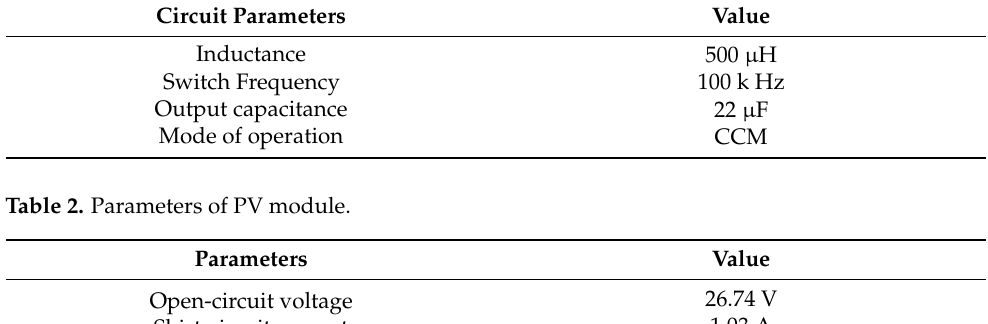
Table 1. Circuit parameters of the boost converter.